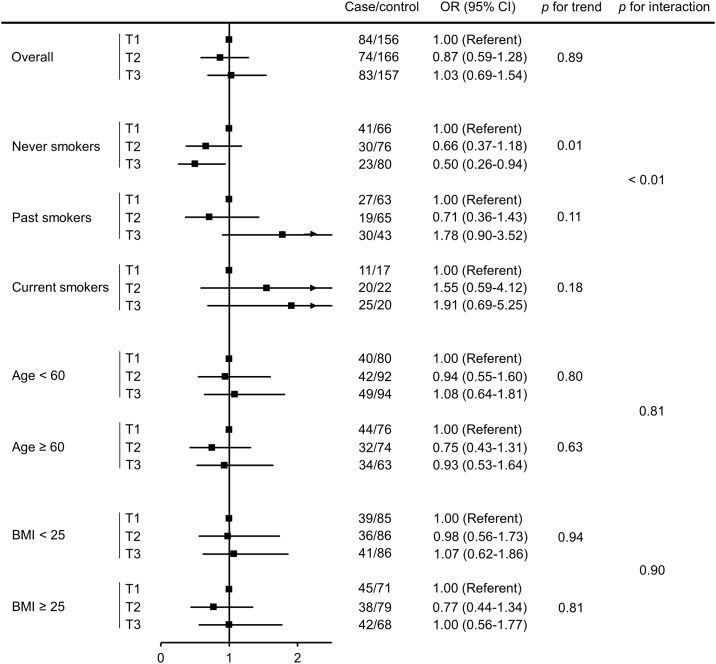
Association between mean taurine and stroke risk overall and stratified.Cut-off points for taurine were determined by tertiles (T1: 64.3–126.6 nmol/mL; T2: 126.7–152.9 nmol/mL; T3: 153.0–308.5 nmol/mL) in the overall population. ORs were calculated using logistic regression conditional on matching factors including age, menopausal status, number and dates of blood donations with additional adjustment for BMI and smoking (except for variables stratified by in stratified analyses). The arrows (for past and current smokers) indicate that the upper limit of the 95% confidence interval was not shown in the figure.